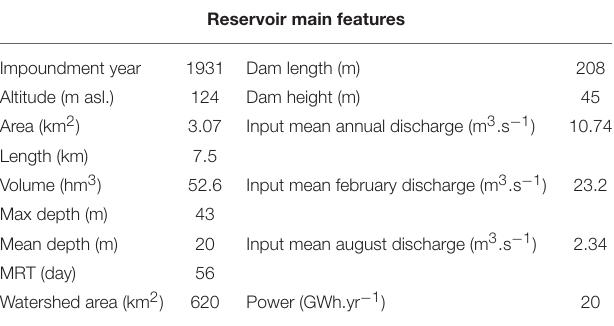
TABLE 1 | Main features of the Guerlédan